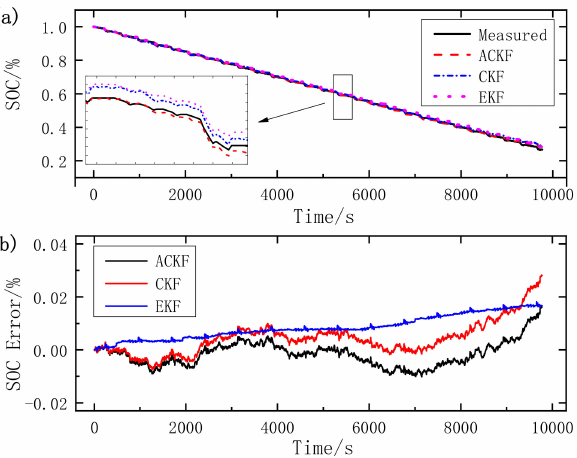
Figure 9. SOC simulation results in DST: ( a ) SOC; ( b ) SOC